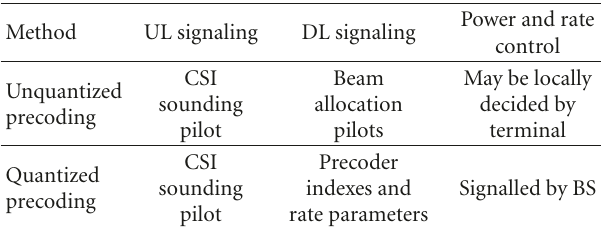
Table 1: UL MU beamforming